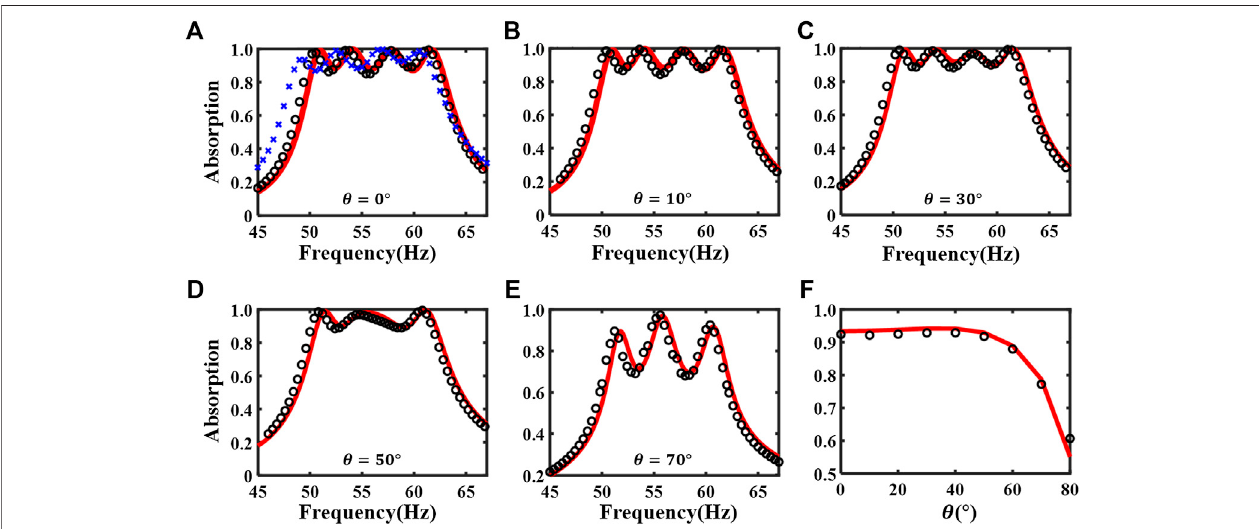
FIGURE2|(A) Thetheoretical(redsolidline),the fi rsttypeofnumerical(blackcircles)andexperimental(bluecrosses)absorptioncoef fi cientatnormalincidencefor thenon-optimizedmetasurfaceabsorber. (B – E) Thetheoreticalandnumericalabsorptioncoef fi cientfortheanglesofincidence10 ° ,30 ° ,50 ° ,and70 ° . (F) Thetheoretical and numerical average absorption coef fi cient over 50 – 63 Hz vs. angle of